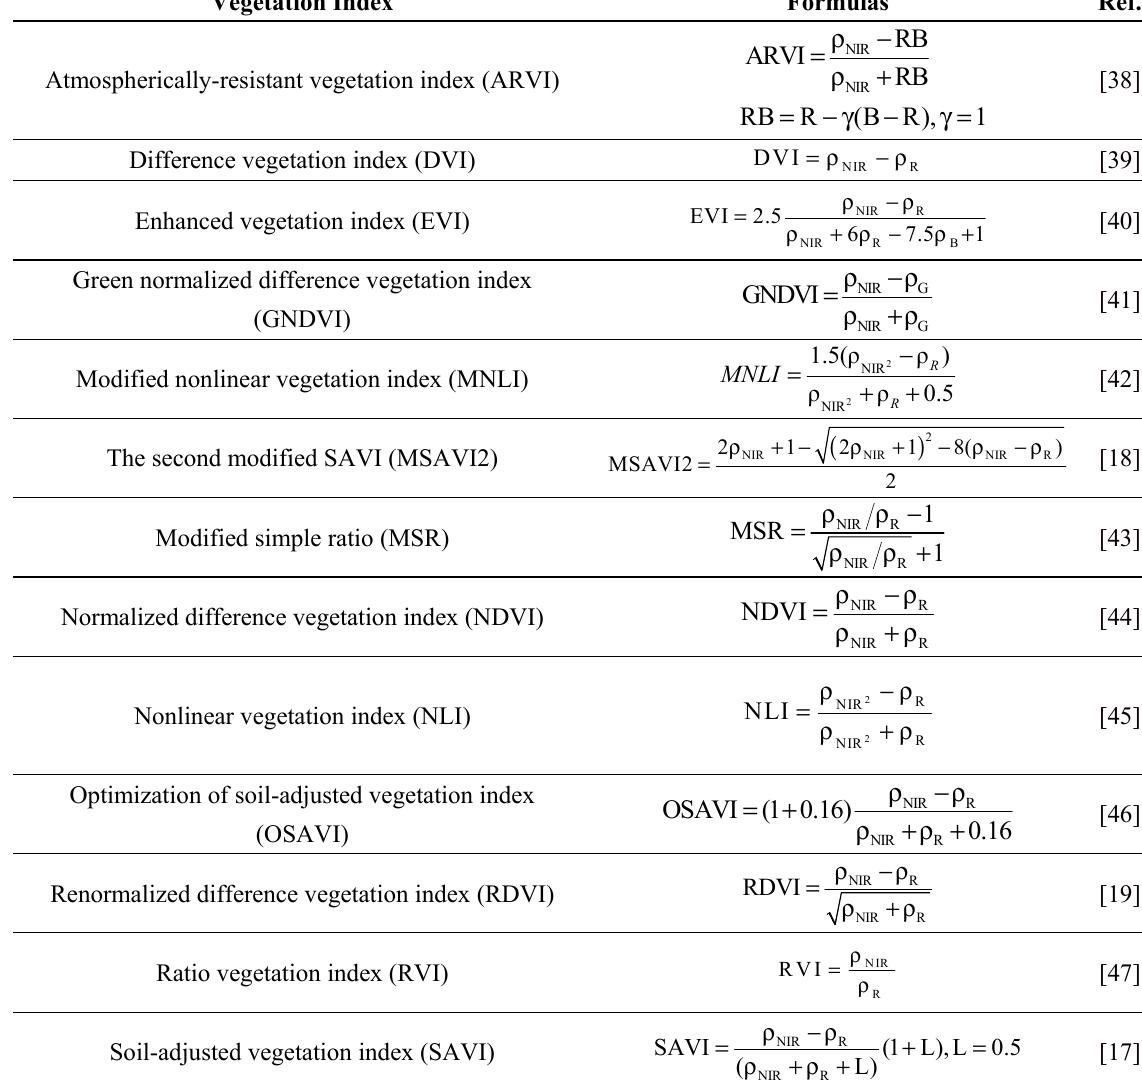
Table 3. Vegetation indices compiled from the literature. Vegetation Index Formulas